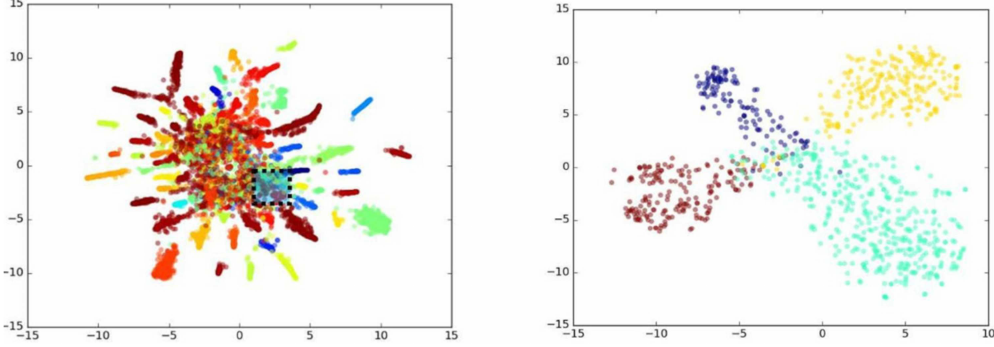
Figure 13. The features extracted by our method.